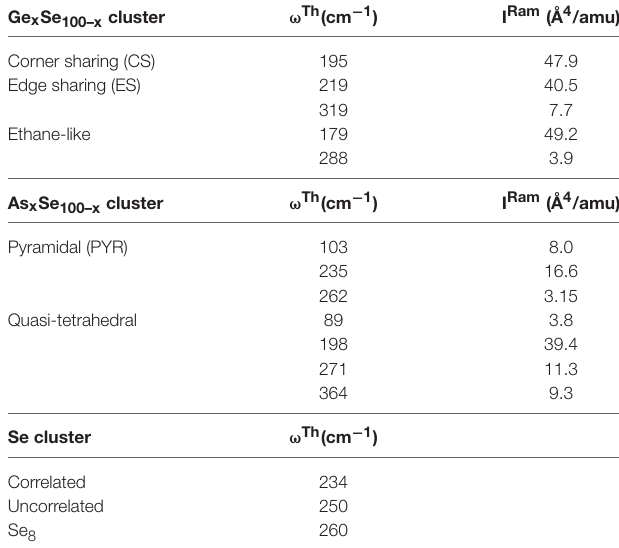
TABLE 1 | Vibrational modes of the Ge-centered CS and ES tetrahedra and Ethane like Ge 2 Se 6 units are included in the top panel, followed by those of the As-centered local structures base on pyramidal and quasi-tetrahedral local structure in the middle panel, and those of the triad of modes related to polymeric Se n Chains in the lowest panel (Jackson et al.,